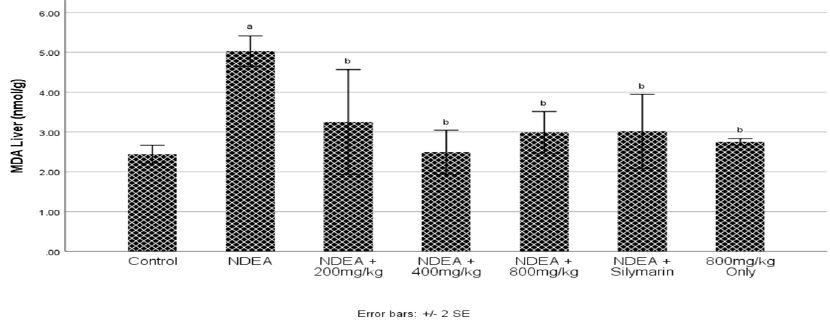
Figure 2. E ff ect of Cajanus cajan on malondialdehyde (MDA). Values are expressed as mean